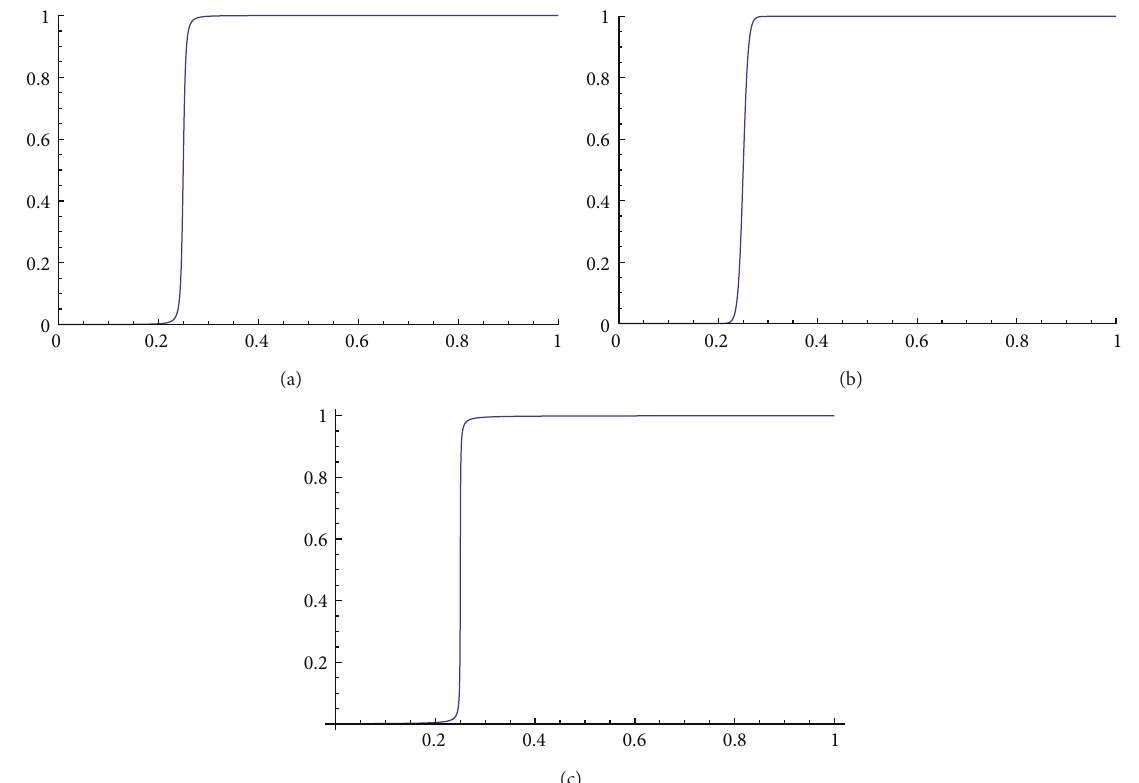
Figure 3: Step function representations 𝑆(𝑢 − 𝑢 𝑖 ) , 𝑆 ⋆ (𝑢 − 𝑢 𝑖 ) and 𝑆 ⋆⋆ (𝑢 − 𝑢 𝑖 ) for 𝑖 = 1 , 𝑙 = 20, 𝑢 𝑖 = 0.25, 𝜖 = 0.01 and 𝑘 = 5